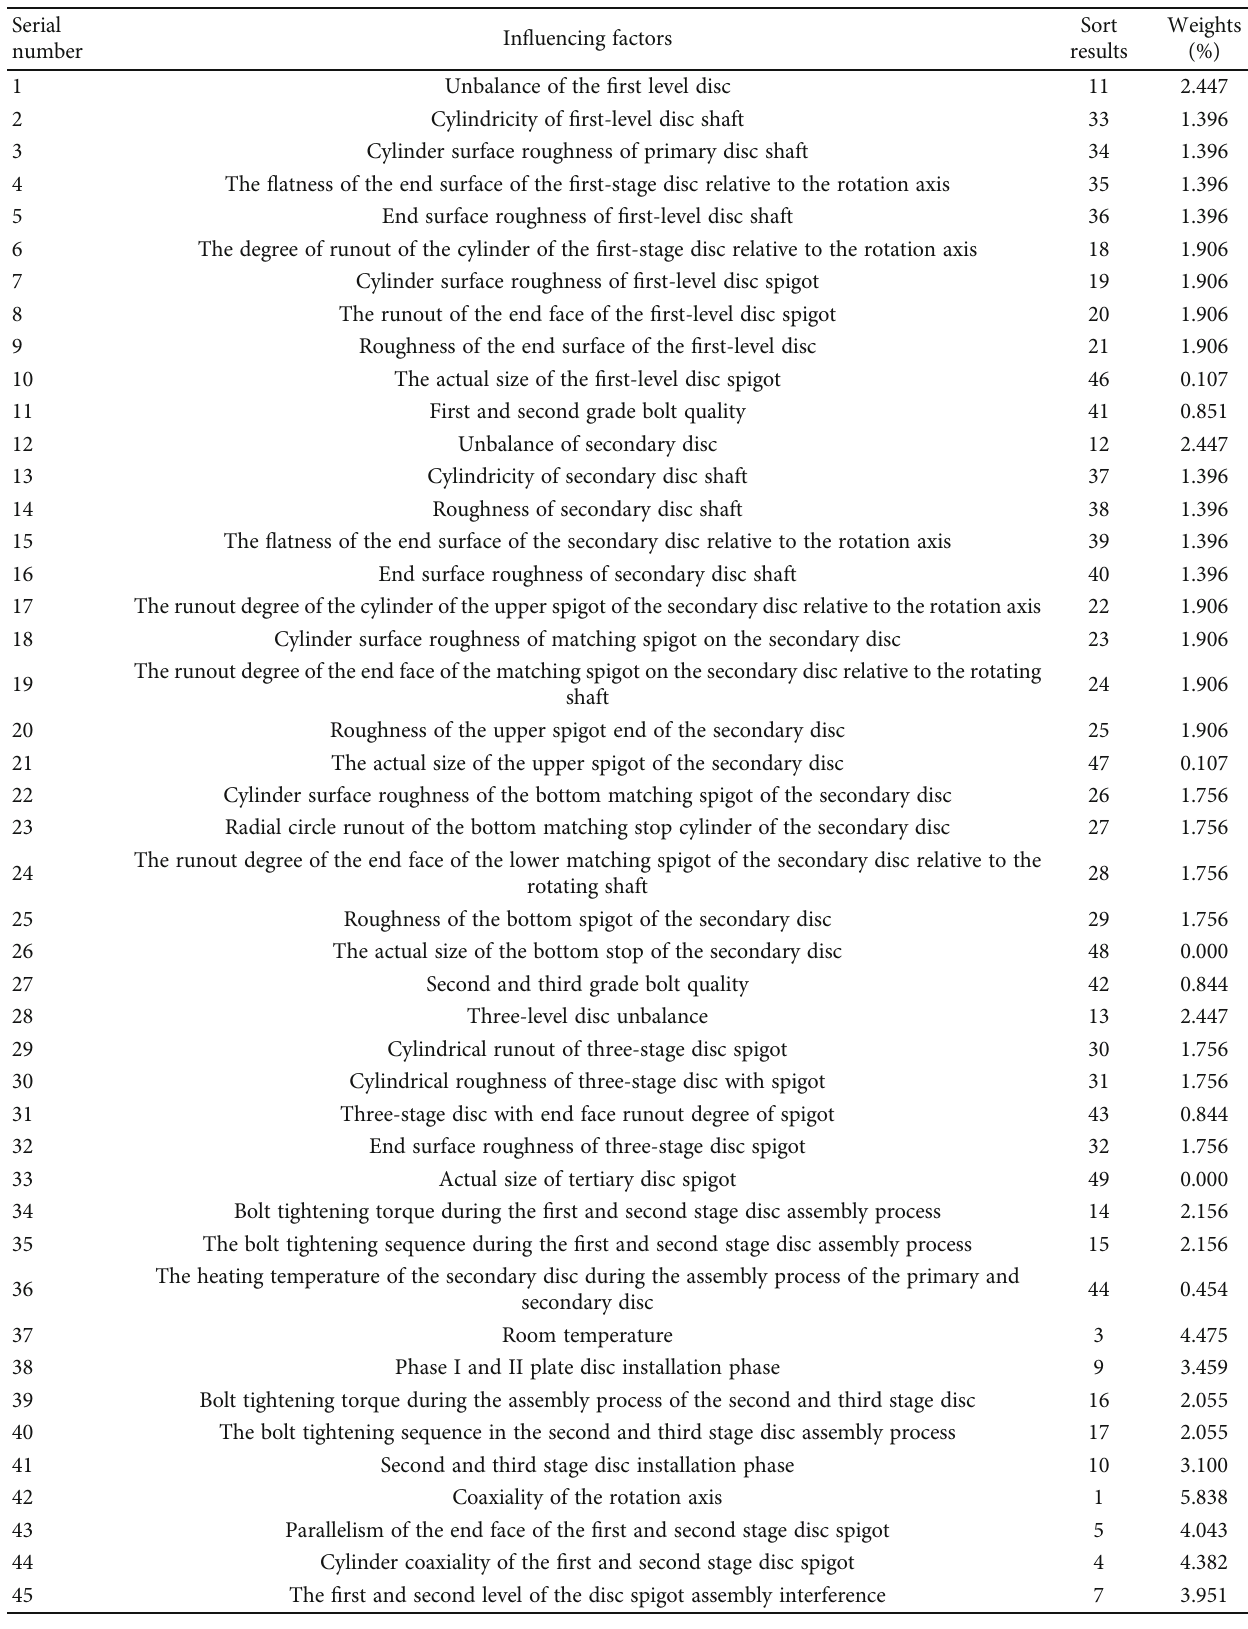
Table 16: Ranking results of key in fl uencing factors of unbalanced quantity of disc assembly